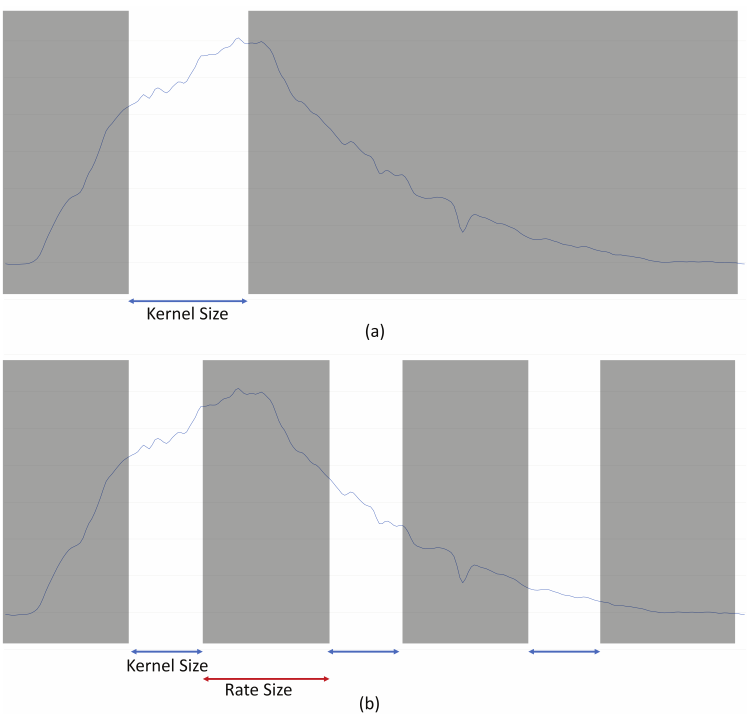
Figure 1. Differences of 1D-Convolution and 1D-Atrous Convolution. ( a ) 1D-Convolution. ( b ) 1D- Atrous Convolution. The gray regions are not included in the calculation when calculating one kernel in the convolution. In general, the 1D-Convolution calculates only limited neighbors, but the 1D-Atrous Convolution calculates far distances as